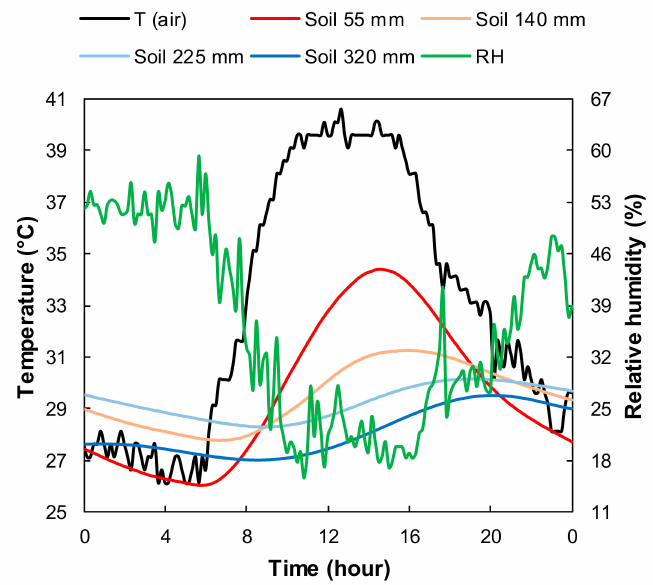
Figure 3. Boundary conditions for the validation of the CFD simulation. Experimental measure- ments of air temperature, relative humidity, and soil temperature on 5 May 2019. T = temperature, RH = relative